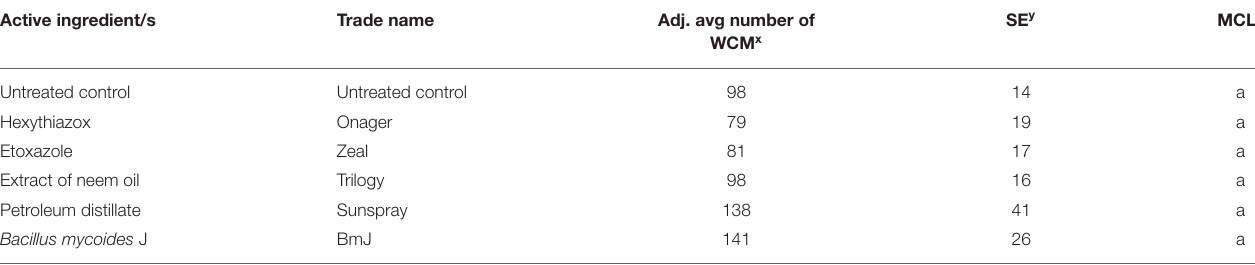
TABLE 3 | Effect of mite growth inhibitor, organic biocontrol, and organic pesticide treatments on average WCM total per plant. Active ingredient/s